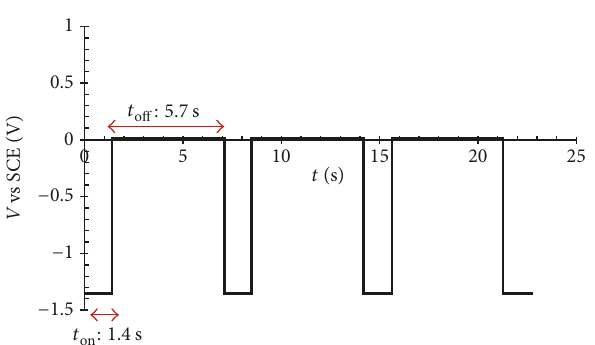
Figure 3: Schematic shape of the applied cathodic pulses during electrodeposition of rGO-Zn nanocomposite ( 𝑡 on = 1.4 ms, 𝑡 off = 5.7 ms, and 𝐷 = 20 %).